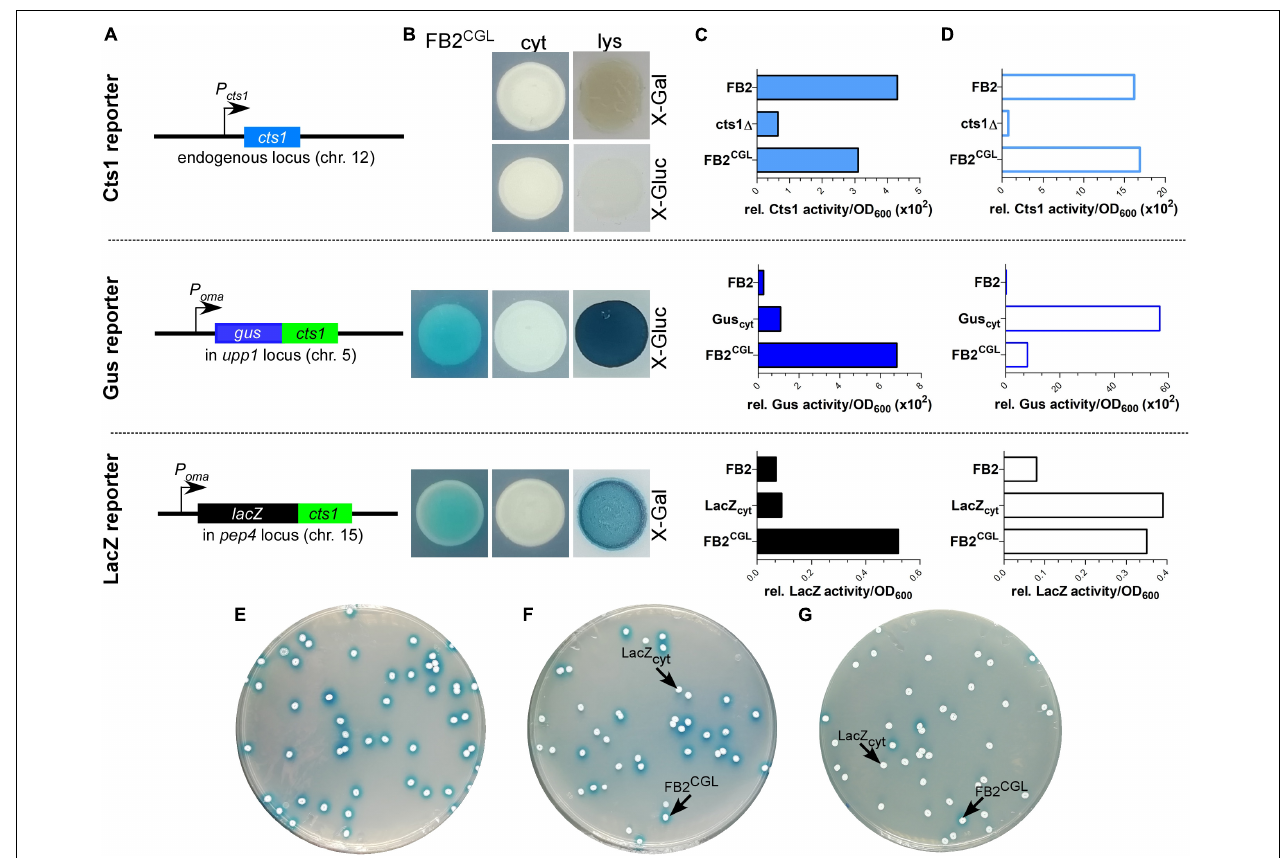
FIGURE 2 | Establishing screening strain FB2 CGL harboring three reporters for unconventional secretion. (A) Scheme of the genetic constructs for the three reporters present in distinct loci of U. maydis strain FB2 CGL . The reporter genes encoding endogenous Cts1 as well as Gus-Cts1 and LacZ-Cts1 are located on three different chromosomes (chr.). While the cts1 gene on chr. 12 has not been modified and is present in its natural setup controlled by its native promoter active in yeast cells, both lacZ:cts1 and gus:cts1 gene fusions were inserted artificially by homologous recombination using described protease loci (16). Both translational fusion genes are hooked up to the strong synthetic promoter P oma which is constitutively active in yeast cells grown on CM-glc. Insertion of the two reporters results in deletion of the genes upp1 and pep4 which both encode harmful extracellular proteases (16). (B) Plate assay to determine the suitability of the used reporters in FB2 CGL in comparison to the lysis controls FB2 Gus cyt and FB2 LacZ cyt harboring cytoplasmic reporter enzymes. FB2 was used as negative control containing neither Gus nor LacZ. X-Gluc and X-Gal were applied as colorimetric substrates for Gus and LacZ, respectively. To visualize intracellular reporter activity, cells were lysed using liquid nitrogen. cyt, control strains with intracellular reporter activity or absent reporter activity. lys, cells lysed by treatment with liquid nitrogen. (C) Liquid assays using the substrates MUG, ONPG, and MUC to determine the suitability of the three reporters Gus-Cts1, LacZ-Cts1 and Cts1, respectively. 10 µ g cell extracts of the indicated strains were used to assay intracellular reporter activities. Upper panel: Cts1 activity based on conversion of MUC; middle panel: Gus activity based on conversion of MUG; lower panel: LacZ activity based on conversion of ONPG. Each assay has been performed in one biological replicate. (D) Liquid assays using the substrates MUG, ONPG and MUC to determine the suitability of the three reporters Gus, LacZ and Cts1, respectively. Culture supernatants (Gus-Cts1/LacZ-Cts1) or intact cells (Cts1) of indicated strains were tested to determine extracellular reporter activities. Upper panel: Cts1 activity based on conversion of MUC; middle panel: Gus activity based on conversion of MUG; lower panel: LacZ activity based on conversion of ONPG. Each assay has been performed in one biological replicate. (E–G) Mixed culture experiments to verify applicability of the LacZ reporter for high-throughput screening on the colorimetric substrate X-Gal. Screening strain FB2 CGL and control strain FB2 LacZ cyt were mixed in the indicated rations and plated onto indicator plates containing X-Gal to visualize extracellular LacZ activity (blue color). Photographs were taken after incubation for 1 day. (E) 100% FB2 CGL ; (F) 50% FB2 CGL /50% FB2 LacZ cyt ; (G) 10% FB2 CGL /90% FB2 LacZ cyt